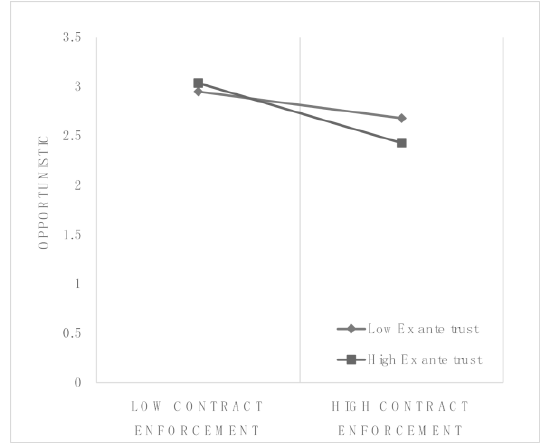
Figure 2. Interaction effect of EAT and CE.